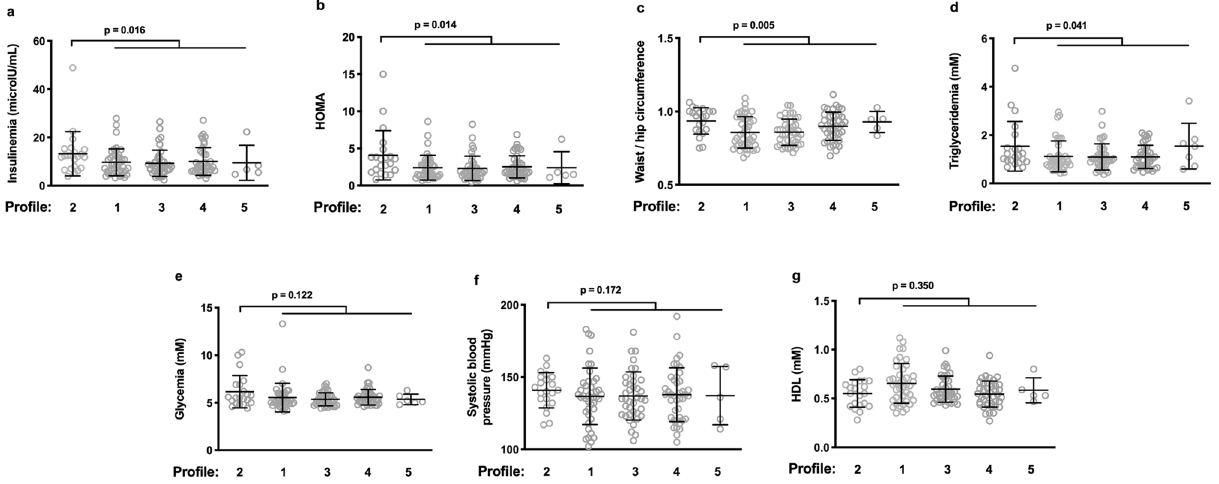
Figure 1. Profile 2 presents with features of insulin resistance and metabolic syndrome. Profile 2 people have higher insulinemia ( a ), HOMA ( b ), waist/hip ratio ( c ), triglyceridemia ( d ), glycemia ( e ), systolic blood pressure ( f ), and HDL ( g ) than the rest of the volunteers.